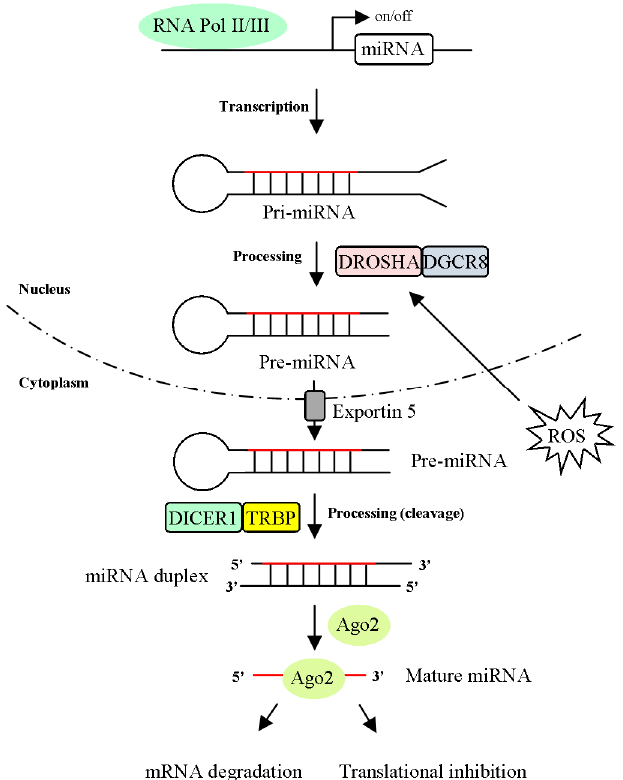
Figure 2. The biogenesis and regulation mechanisms of microRNAs (miRNAs). MiRNAs are transcribed by RNA polymerase II / III and generated the primary miRNA transcript (pri-miRNA). The pri-miRNAs are cleaved into precursor miRNA transcript (pre-miRNA) by the microprocessor complex, a combination of DROSHA and DGCR8. Pre-miRNA is exported to cytoplasm via exportin 5 and further processed by the RNase III enzyme Dicer with the cofactor protein TRBP to generate an approximately 18-25-nt duplex. Either 5p or 3p strand of the mature miRNA (red line) interacts with Argonaute (Ago) protein and forms a miRNA-induced silencing complex (miRISC). There are two models (mRNA degradation and translational repression) of miRNA-mediated gene